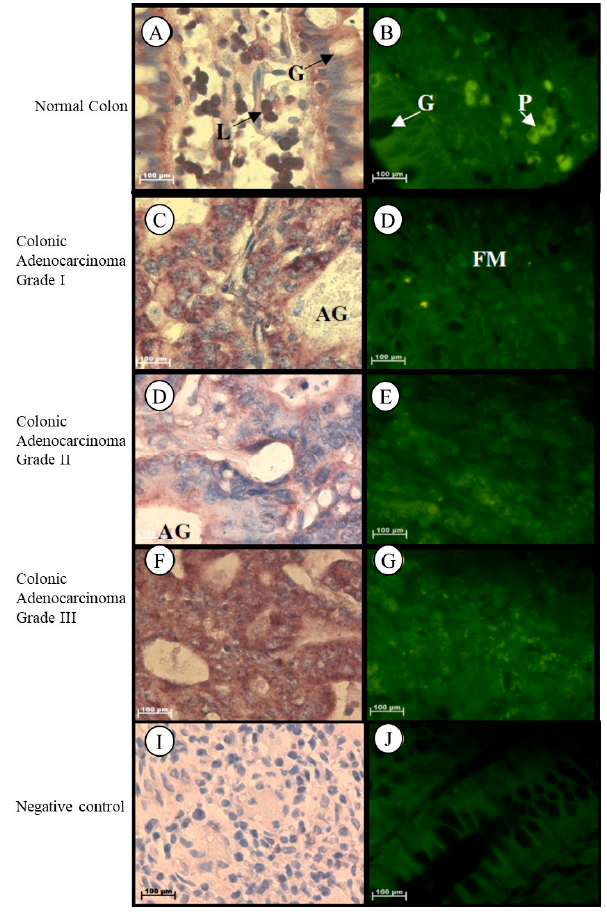
Figure 3. Localization of Tspo mRNA in healthy and diseased colon tissue. Tspo mRNA was localized in the cytoplasm of goblet (G) and absorptive cells of the Crypts of Lieberkhün and plasma cells (P) located in the lamina propria, and in the nuclei and cytoplasm of lymphocytes (L) located in the lamina propria of normal colon tissue ( A , B ). Localization of the Tspo mRNA was found in the cytoplasm of tumour cells that are mucin-secreting and arranged in adenomatous tubular glands (AG) and fibromuscular stroma (FM) of Grade I colonic adenocarcinoma ( C , D ). In Grade II colonic adenocarcinoma, Tspo mRNA was localized in the cytoplasm of tumour cells arranged as adenomatous glands (AG) or solid sheets ( E , F ). Tspo mRNA was localized in the cytoplasm of tumour cells that are predominantly arranged as a solid pattern of Grade III colonic adenocarcinoma ( G , H ). ( I , J ) Negative control for the subcellular localization of Tspo mRNA. Sense probes were used to probe tissue preparations and this was analysed colorimetrically and fluorescently . Tissues were magnified at 1000×.